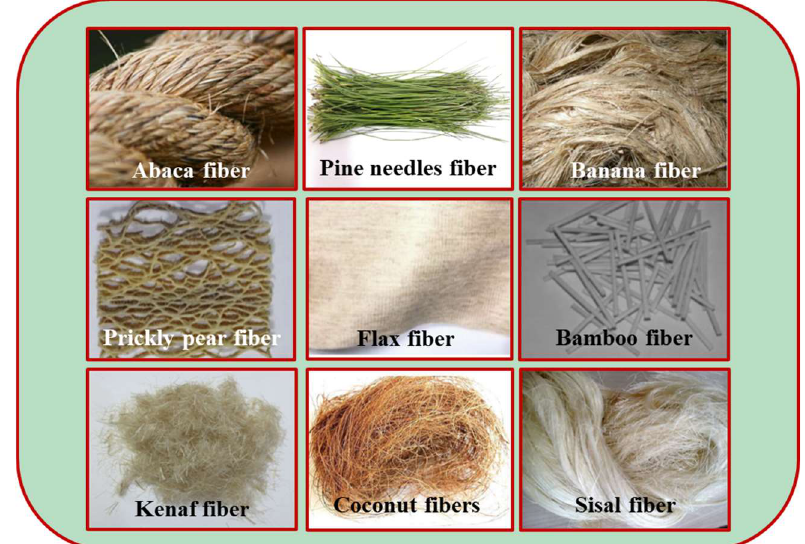
Figure 9. Typical types of plant fiber.